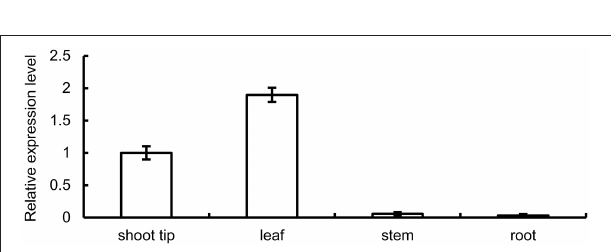
FIGURE 2 | Quantitative RT-PCR analysis of BpMYB106 relative expression level in different tissues of birch. Genes were normalized using 18S as housekeeping genes. Error bars on each symbol indicate the mean ± SE of three replicate reactions.